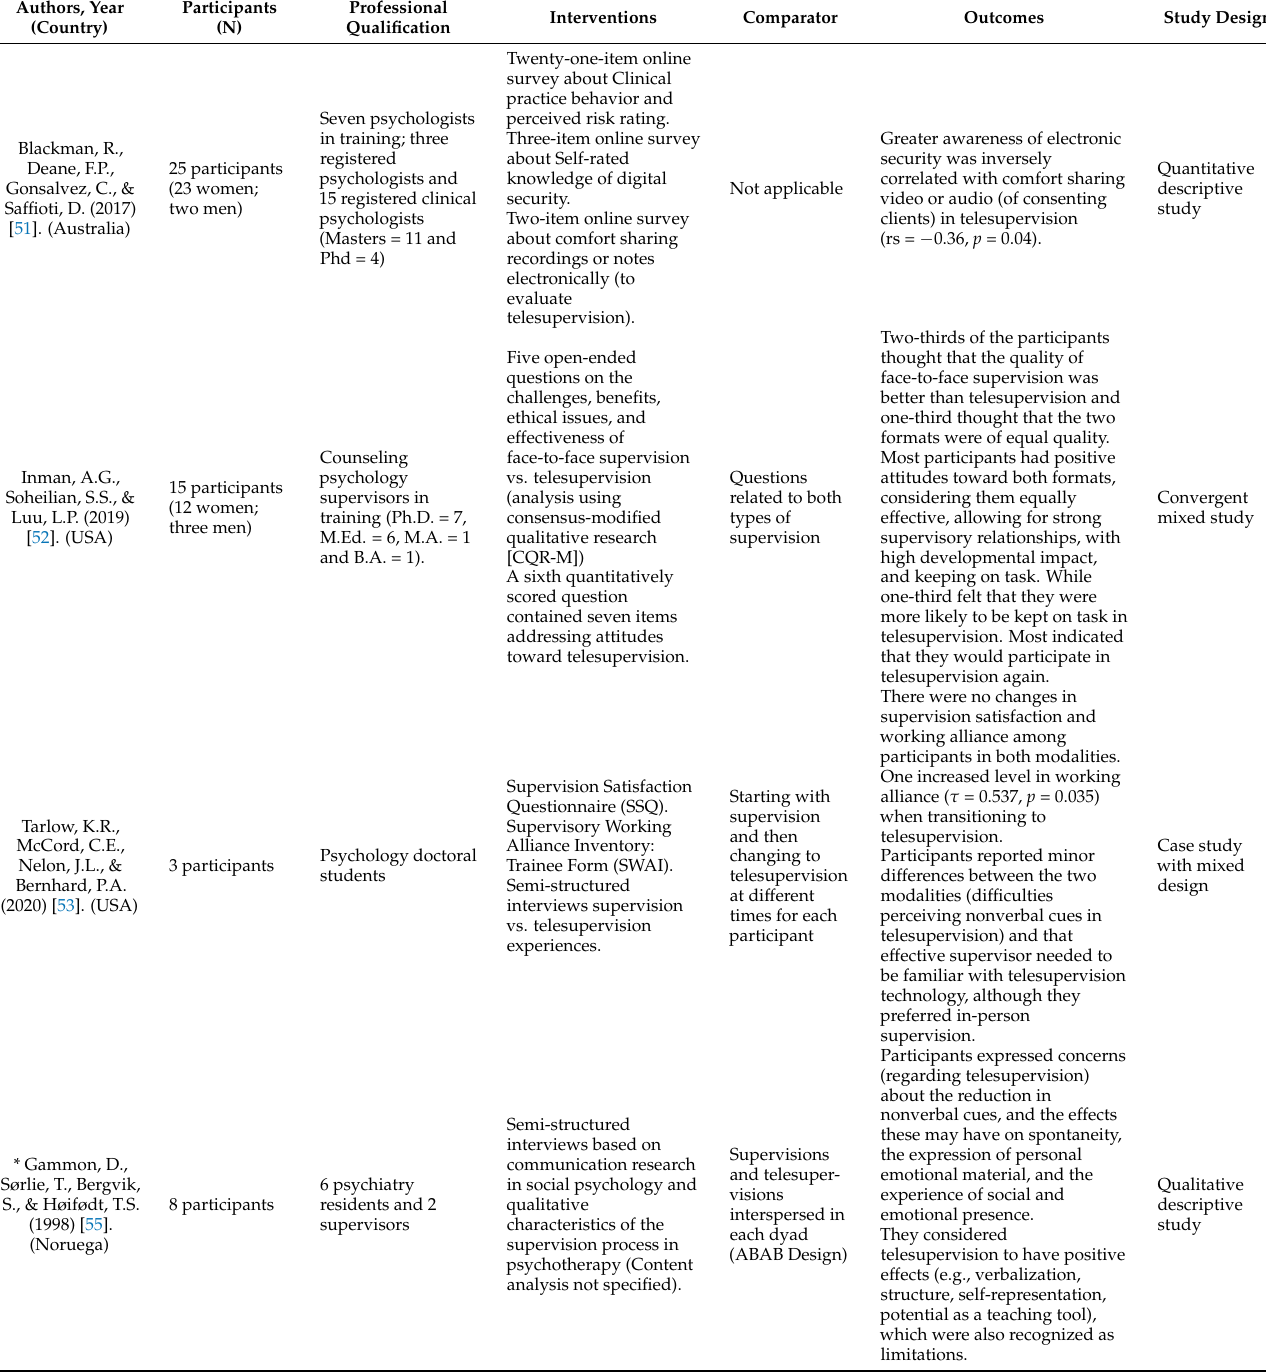
Table 3. Characteristics of the reviewed